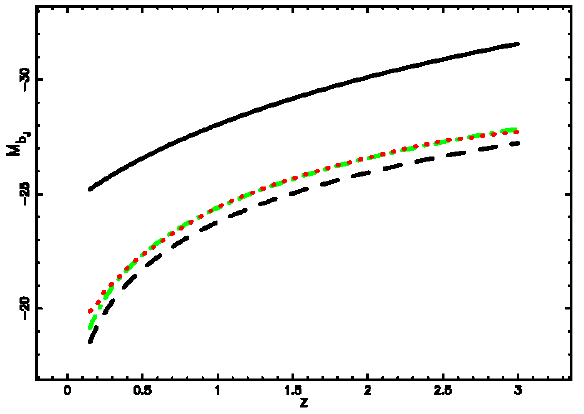
Figure 7. Average observed absolute magnitude versus redshift for QSOs (red points), average theoretical absolute magnitude for truncated Schechter LF as given by Equation (30) (dot-dash-dot green line), theoretical curve for the empirical lowest absolute magnitude at a given redshift, see Equation (42) (full black line) and the theoretical curve for the highest absolute magnitude at a given redshift (dashed black line), see Equation (37), RSS = 1.212.